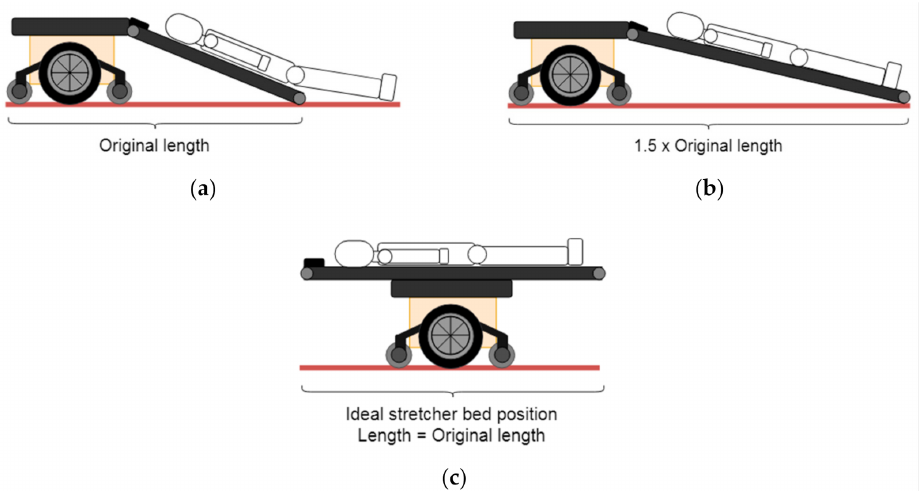
Figure 4. Illustration showing the ResQbot 1.0 stretcher-bed conveyor in comparison to the longer stretcher-bed conveyor designs that enable safe loading of the casualty’s entire body onto the stretcher bed. ( a ) ResQbot 1.0 original size. ( b ) ResQbot 1.0 with an expanded stretcher bed. ( c ) The ideal position of the stretcher bed on the differential-drive mobile base (i.e., proposed